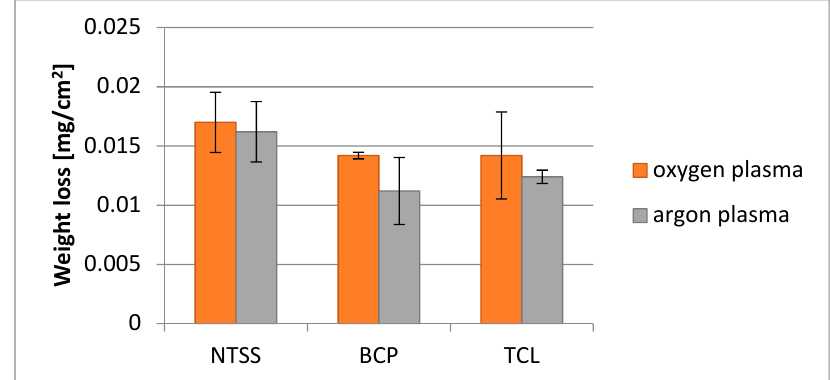
Figure 5. Weight change in samples due to plasma activation.